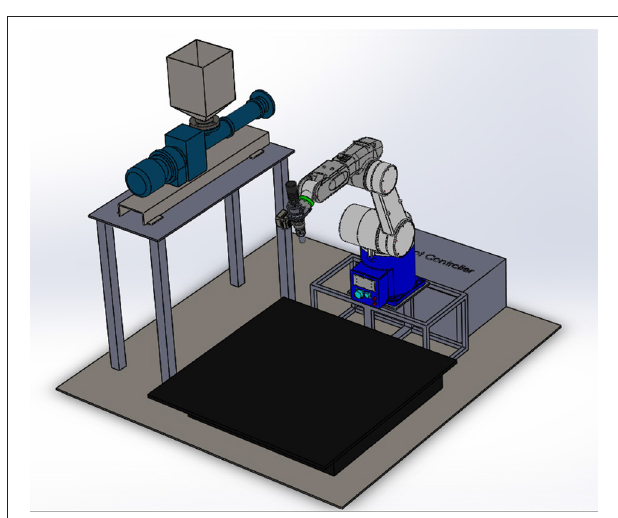
FIGURE 4 | Graphical explanation of extrusion printing using 6 DOF robot with a progressive cavity